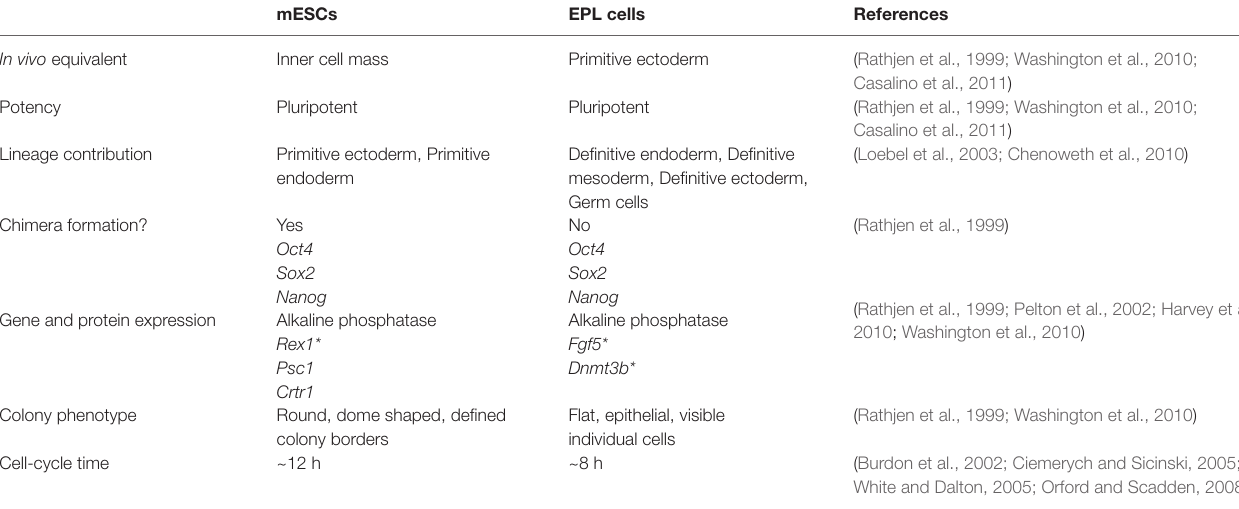
TABLE 1 | Comparison of mouse embryonic stem cells (mESCs) with early primitive ectoderm-like (EPL)